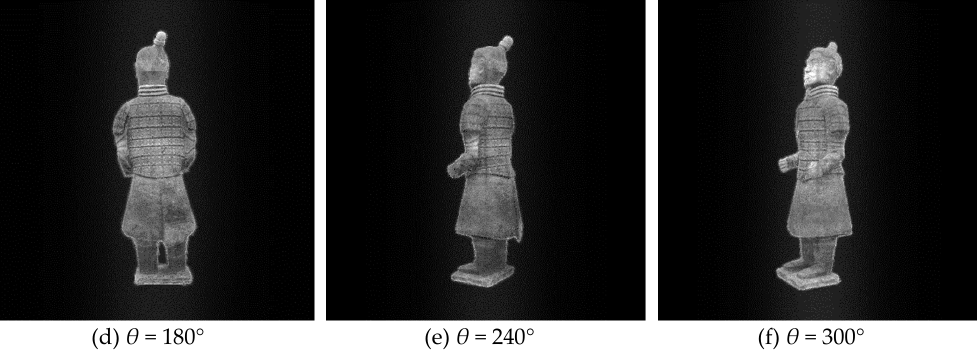
Figure 6. Digital reconstructed images at different viewing angles with kinoform sequence scheme II.